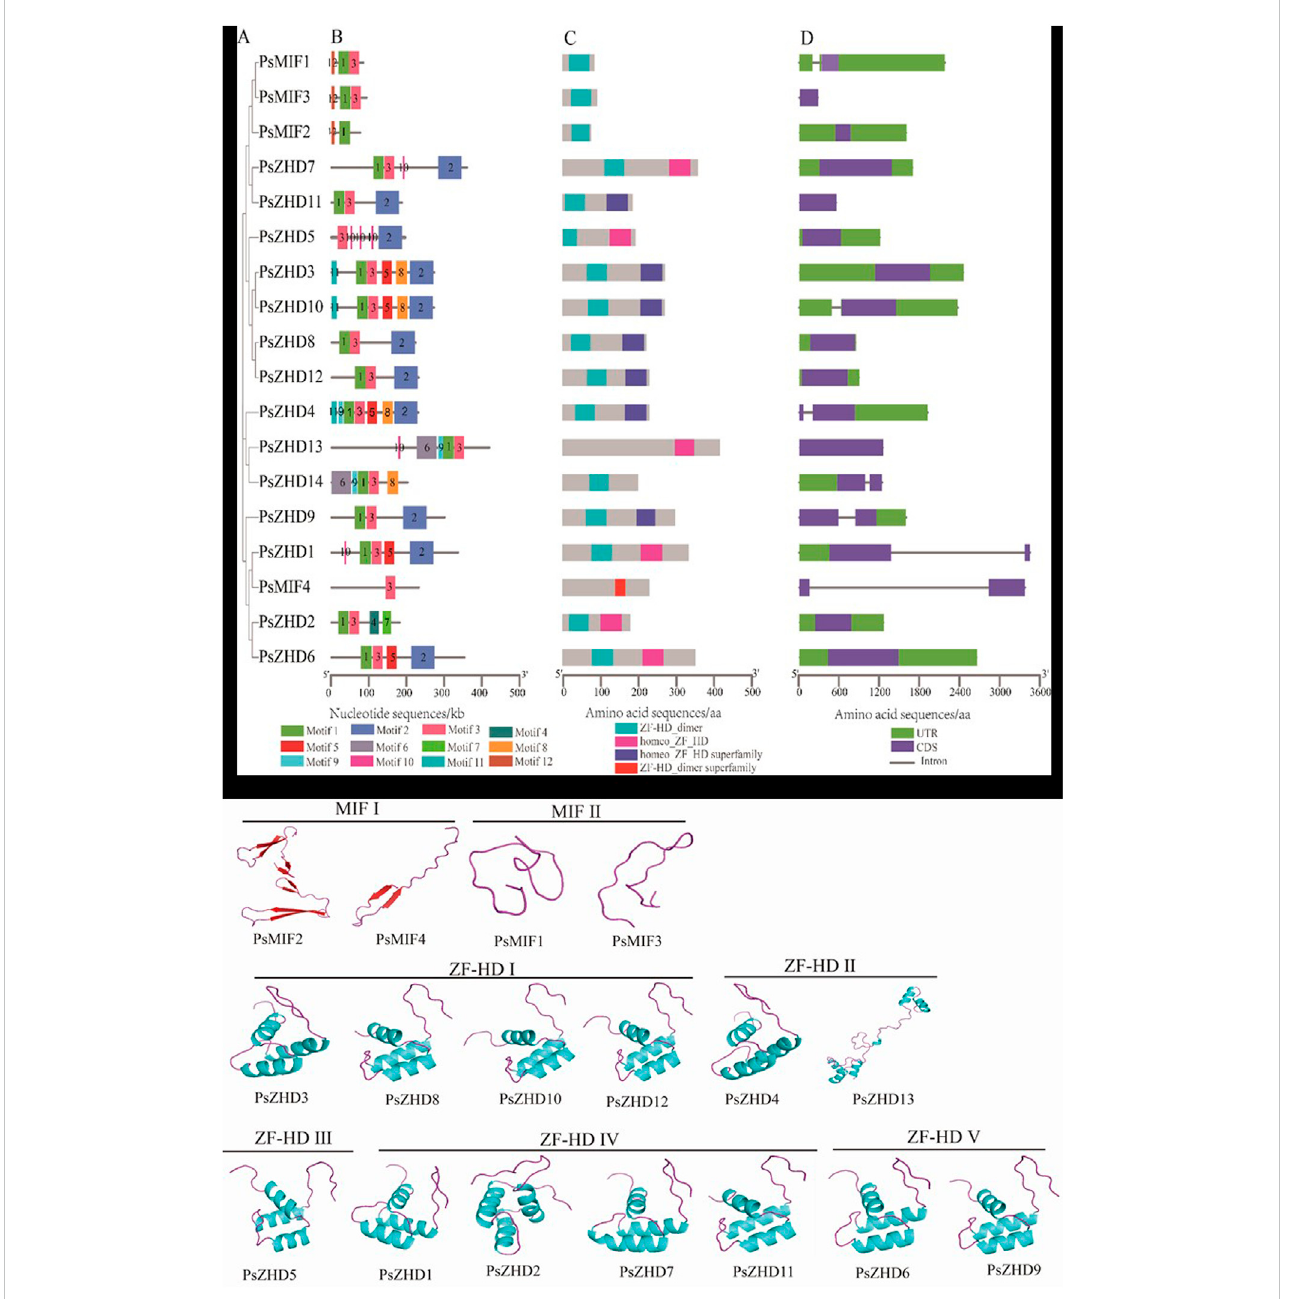
FIGURE 3 Phylogenetic relationship, conserved motifs, conserved domain and gene structure of the PsZF-HD genes. (A) An unrooted phylogenetic tree was constructedbytheMEGAXbasedonPeaZF-HDproteinsequencesusingtheMaximumlikelihoodmethod. (B) ConservedmotifcompositionofthePsZF-HD proteins, and the colored box at the bottom represented the relative position of each conserved motif, Details are shown in Supplementary File S2. (C) conserved domain composition PsZF-HD proteins. (D) The CDS – UTR-introns structures of PsZF-HD genes were displayed by TBtools software.